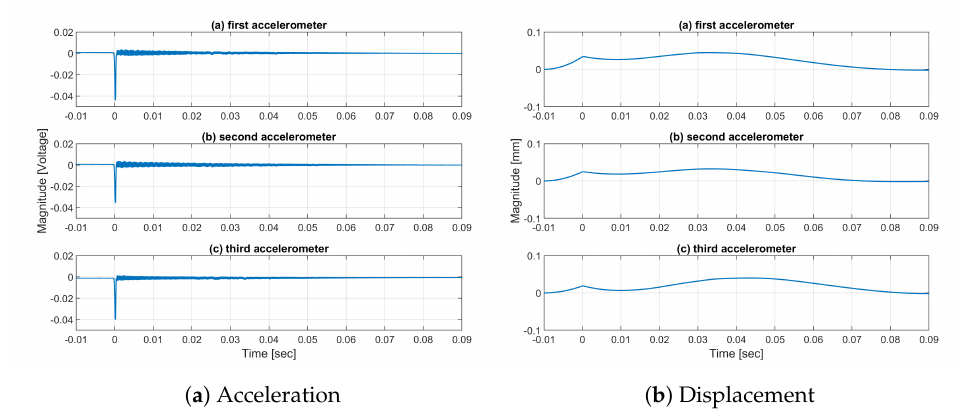
Figure 7. Typical acceleration and displacement of the new 60 grit wheel.